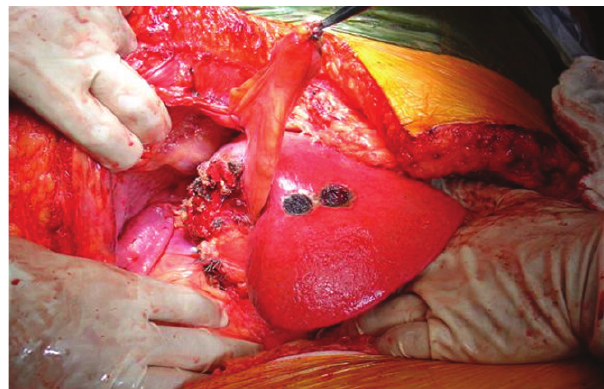
Figure 4 - Patient with bilateral liver metastases. After portal vein embolization of the right liver, an extended right hepatectomy was performed with enucleation of the left